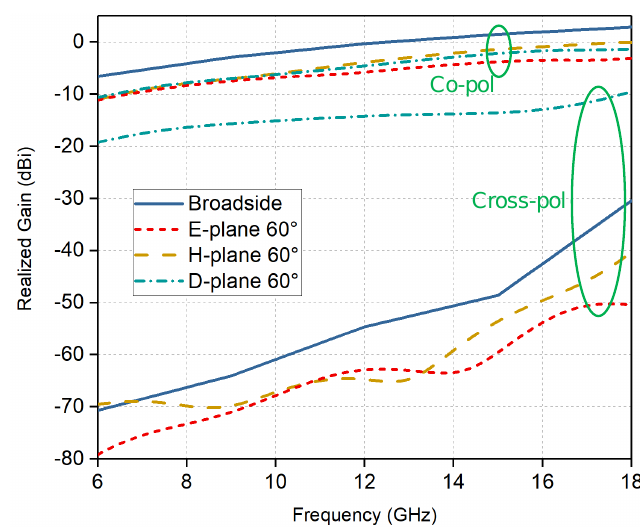
Figure 11. Simulated realized gains (co-polarization and cross-polarization) per unit cell of the proposed array for broadside and wide-angle scanning cases in all planes.